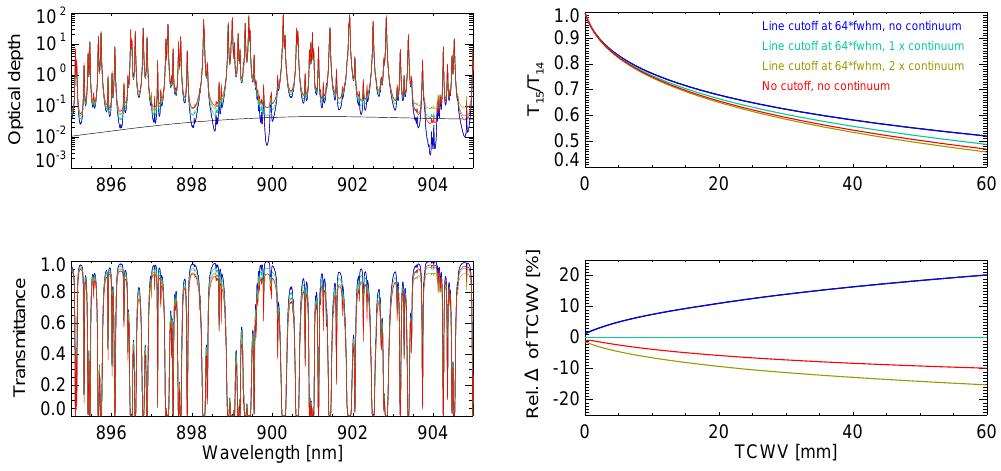
Fig. 11. Left panels: sensitivity of optical depth (upper figure) and transmittance (lower figure) at 900nm to spectroscopic assumptions. The colors of the curves denote the underlying line cutoff width and continuum absorption, as indicated in the upper right plot. The continuum optical depth is shown in black in the upper left panel. Right panels: Transmittance ratio of MERIS bands 15 and 14 as a function of TCWV (upper) and corresponding relative difference of derived TCWV, in relation to retrieval based on line cutoff at 64 · fwhm and a MT-CKD